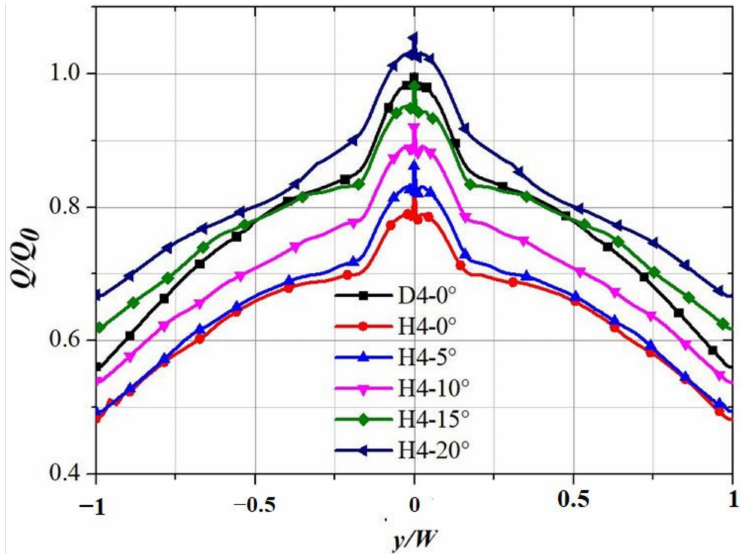
Figure 14. Spanwise distribution curves, including peak heat